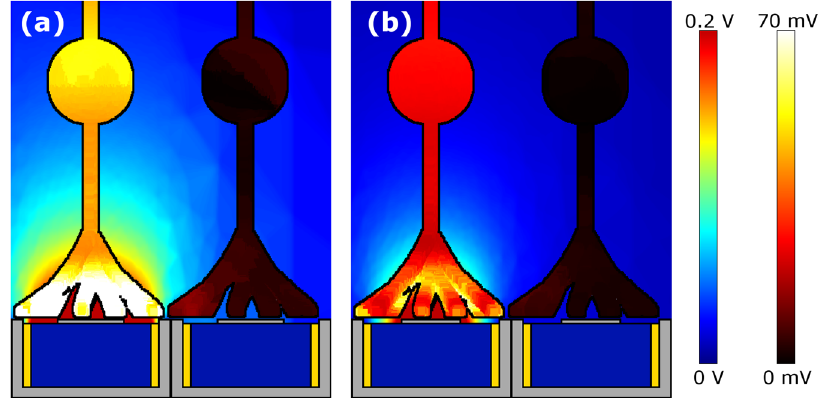
Figure 6. Side-view of neurons above two neighboring photodiodes with ( a ) fractal and ( b ) square electrode geometries. For both geometries, each photodiode features the inner and outer grounded electrodes shown in Fig. 1. In each case, the inner electrode of the left photodiode was biased at V 0 = 0.32 V and f = 1 kHz, while the inner electrode of the right photodiode was unbiased. Scale bar for the electrode’s field ranges from 0 V (blue) to 0.2 V (red). Scale bar for the neuron stimulation ranges from 0 mV (black) to 70 mV